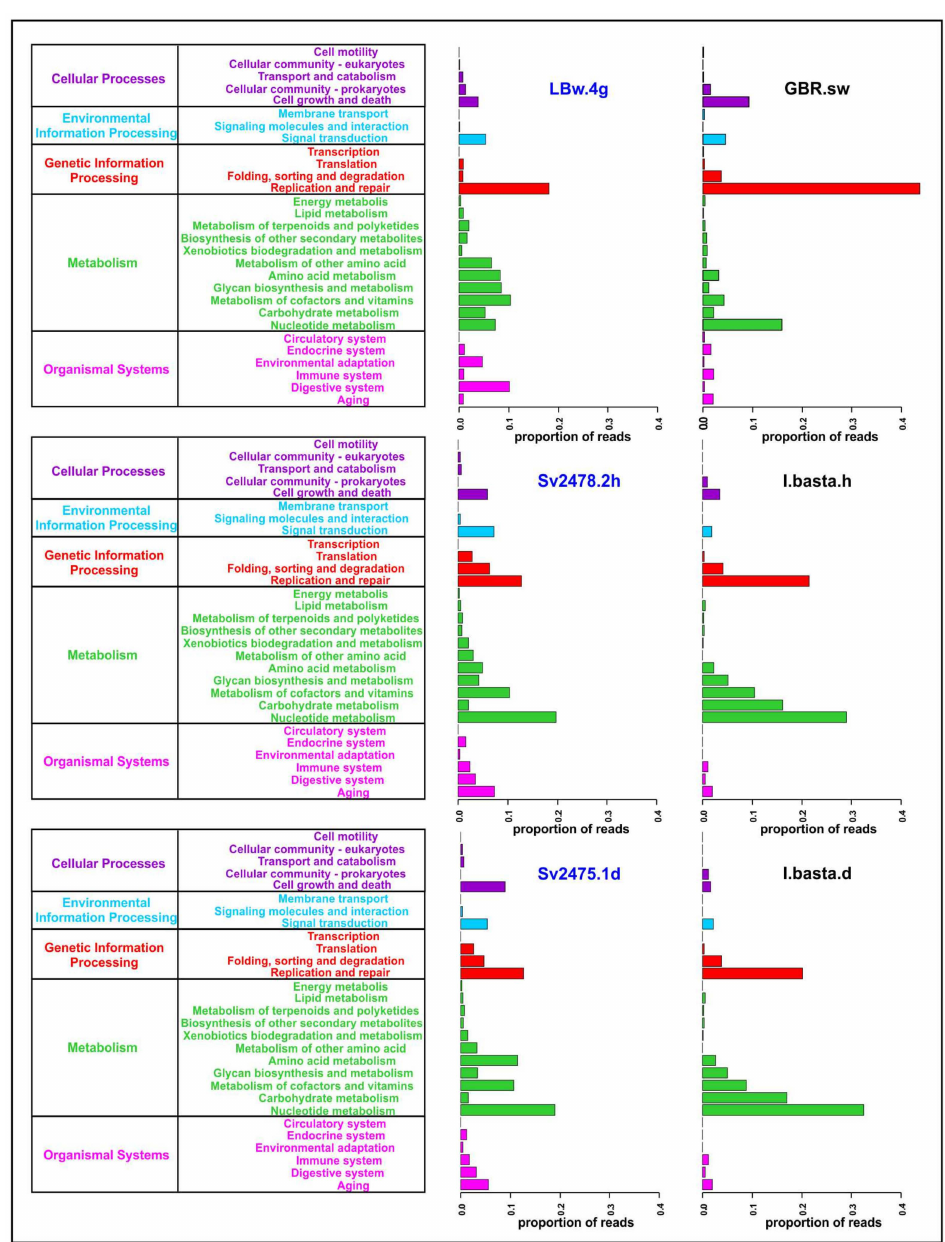
Figure 3. General functional annotation of the sponge and water viromes analyzed in the study (the main and secondary functional categories are indicated, according to the KEGG Orthology). The Baikal samples are highlighted in